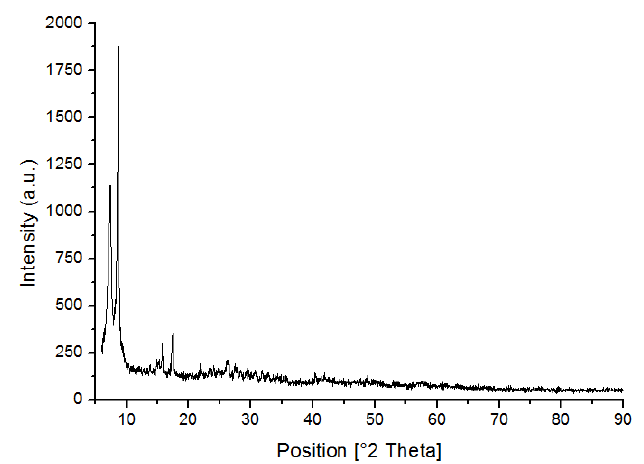
Figure A2. XRD patterns of UiO-66 particles from 5° to 90°.